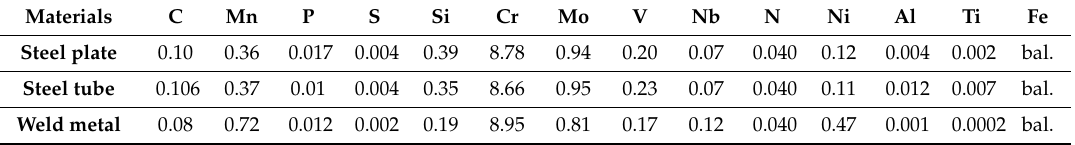
Table 1. The chemical composition (in wt.%) of Gr. 91 steel plate, tube, and weld metal.